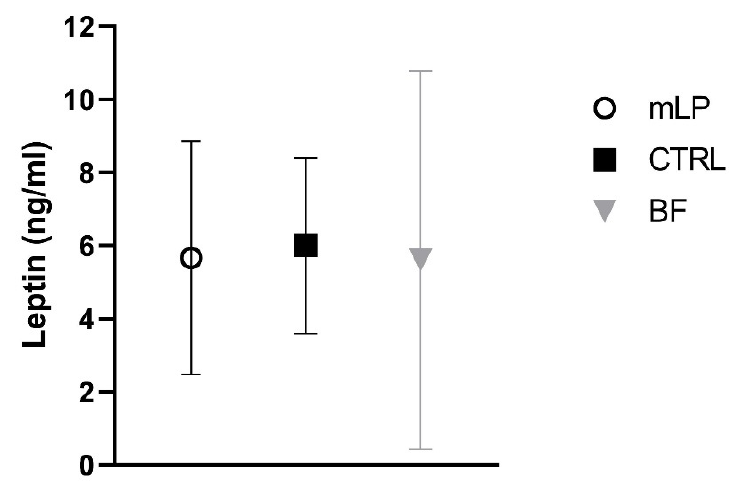
Figure 1. Leptin at 4 months of age. Mean ± SD.